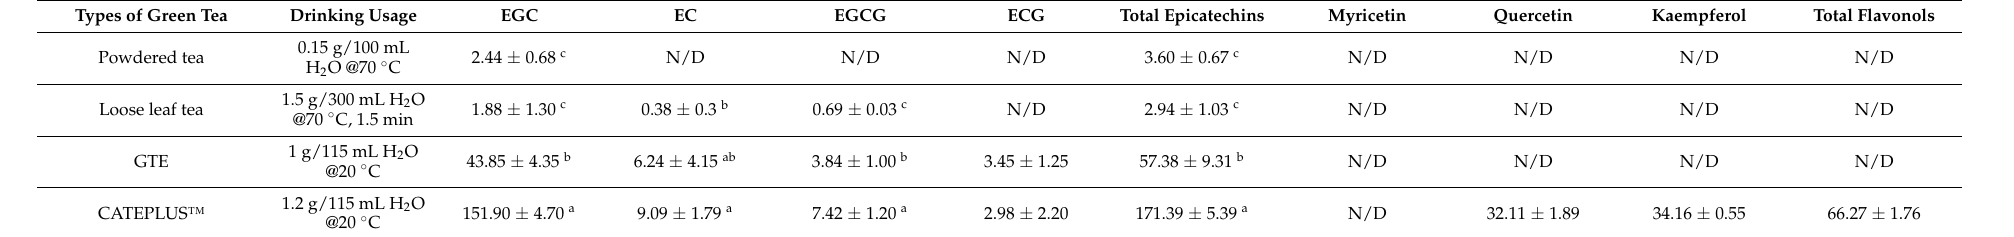
Table 4. Content of epicatechins and flavonols in Caco-2 cells (ng/mg